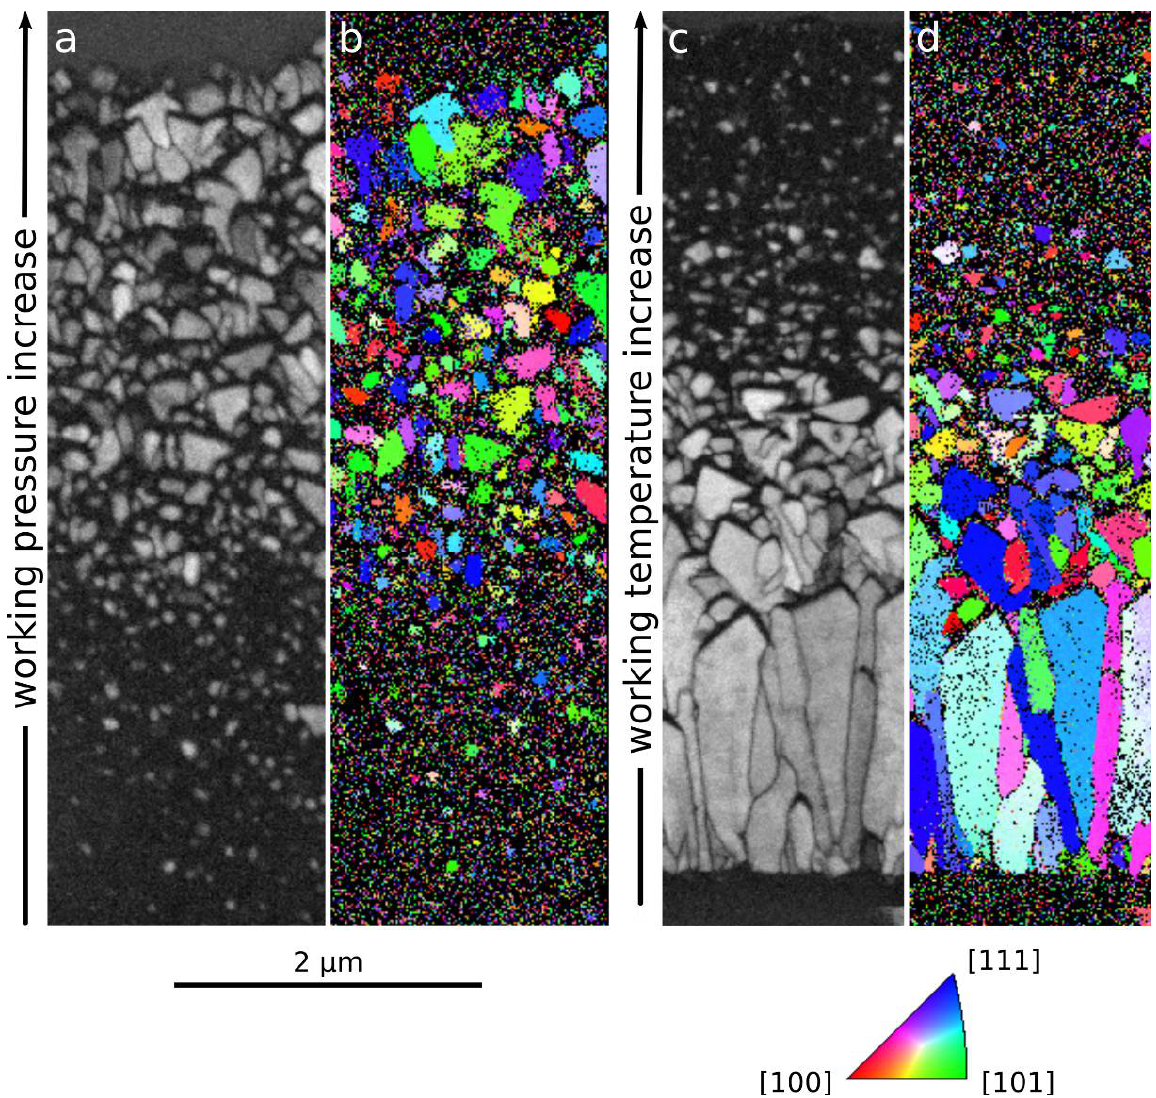
Figure 3. Transmission electron back scatter diffraction (EBSD) from the p- ( a , b ) and T-coating ( c , d ). In ( b , d ), orientation maps show the in-plane orientation of cubic crystallites. In ( a,b ), the transmission EBSD (tEBSD) indexing reliability documents the occurrence and morphology of cubic grains at both coatings’ cross-sections.